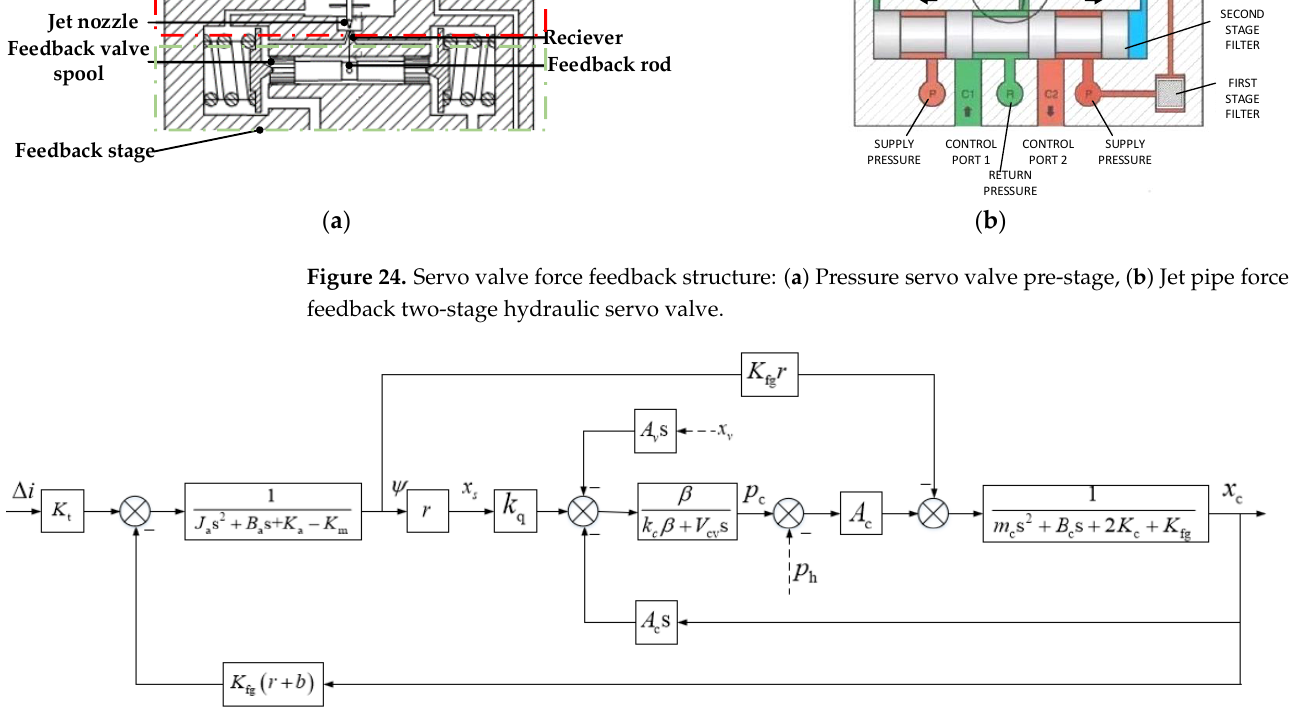
Figure 24. Servo valve force feedback structure: ( a ) Pressure servo valve pre-stage, ( b ) Jet pipe force feedback two-stage hydraulic servo valve.